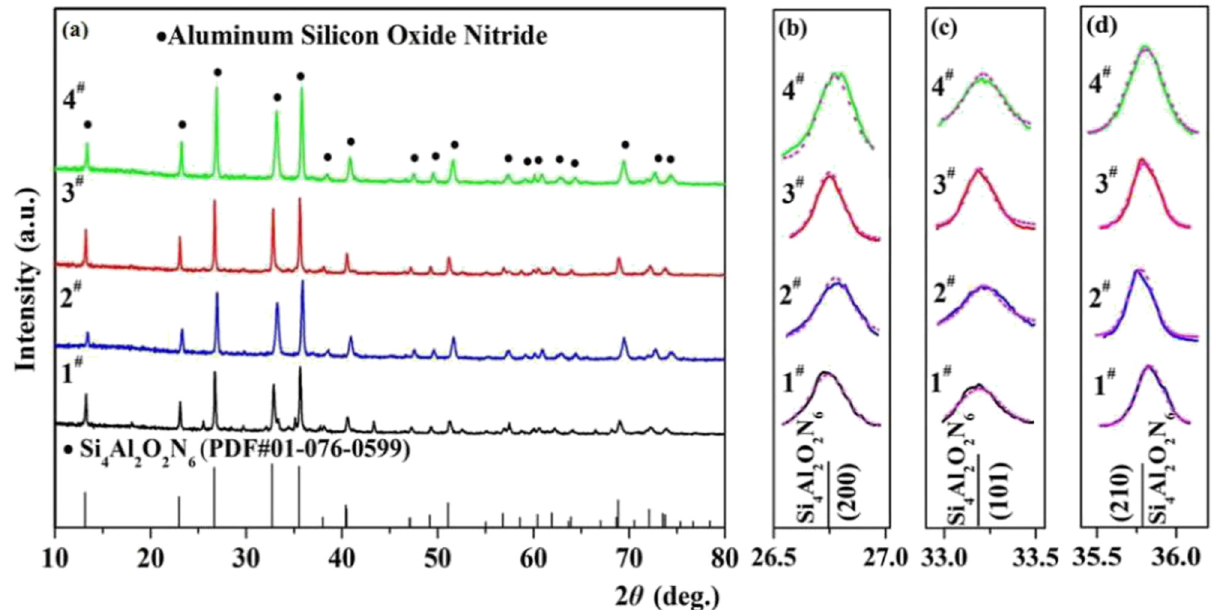
Figure 3: XRD patterns the Si 4 Al 2 O 2 N 6 powders with 2 θ range of ( a ) 10° – 80°, ( b ) 26.5° – 27°, ( c ) 33° – 33.5° and ( d ) 35.5° –